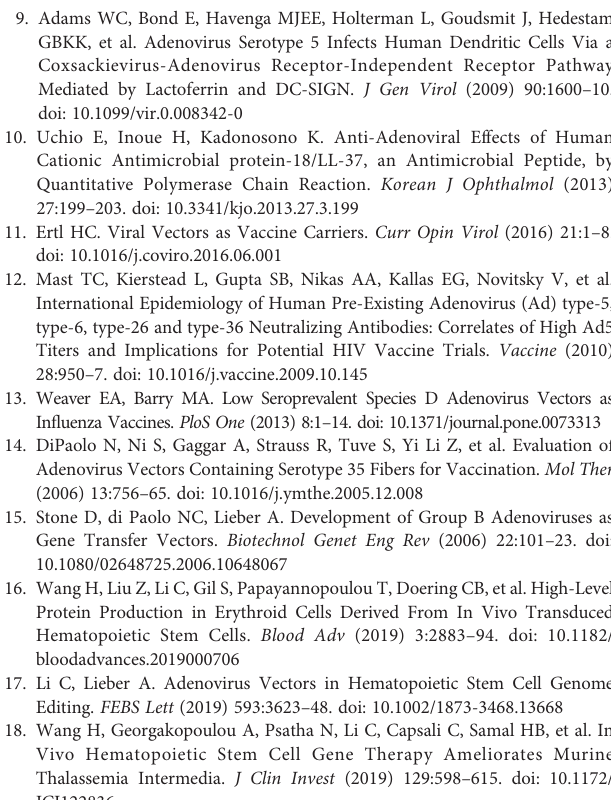
Supplementary Figure 4 | EffectofpharmacologicalinhibitiononHAdVinfection (A) IL-1 b releasefollowinginhibitionofpyroptosisinitiators(n ≥